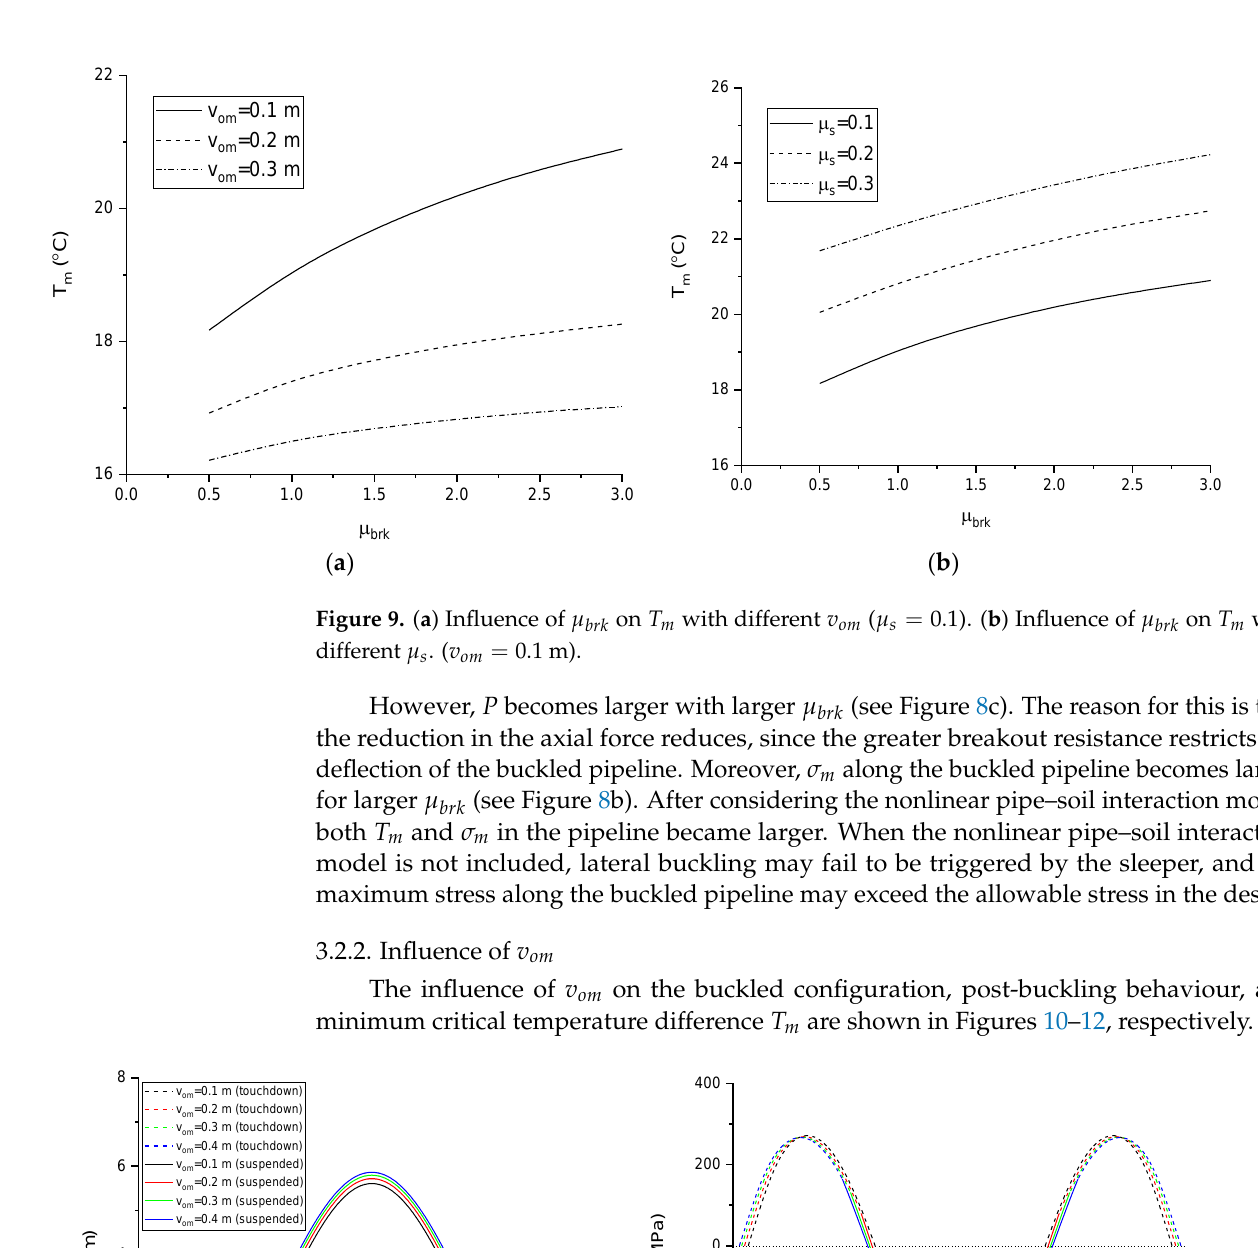
Figure 9. ( a ) Influence of 𝜇 𝑏𝑟𝑘 on 𝑇 𝑚 with different 𝑣 𝑜𝑚 ( 𝜇 𝑠 = 0.1 ). ( b ) Influence of 𝜇 𝑏𝑟𝑘 on 𝑇 𝑚 with different 𝜇 𝑠 . ( 𝑣 𝑜𝑚 = 0.1 m).